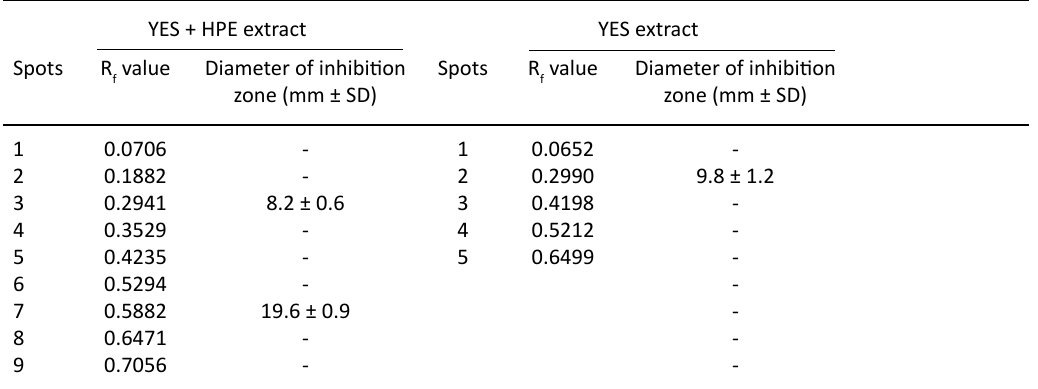
Table 5. Anti-MRSA activity of different spots on TLC observed under short wave UV light YES + HPE extract YES extract Spots R value Diameter of inhibition Spots f